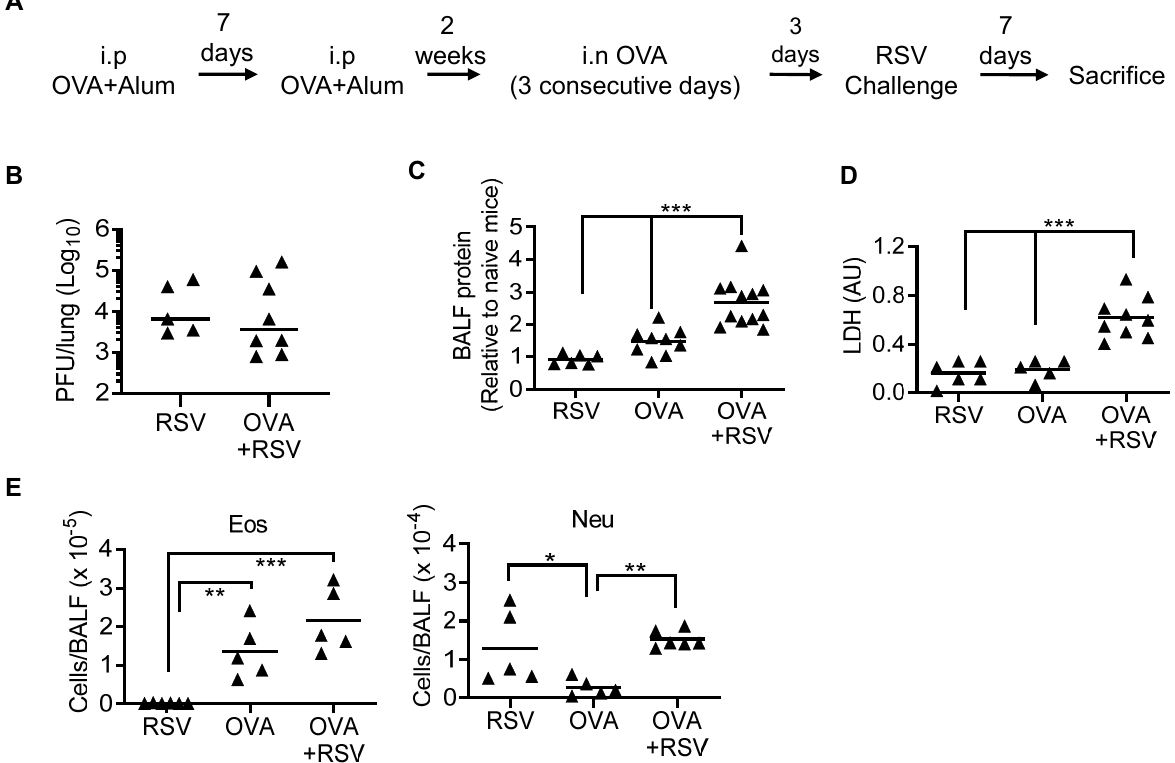
Figure 2. RSV infection of WT mice with OVA-induced asthma increases eosinophilic and neutrophilic inflammation. ( A ) Scheme of the experimental design. ( B ) Lung RSV titers, ( C ) airway protein and ( D ) LDH levels, ( E ) numbers of airway eosinophils (Eos) and neutrophils (Neu) in the BALF at day 7 after RSV infection of OVA-induced asthmatic C57BL/6 WT mice. Corresponding control mice were treated with PBS. AU, Arbitrary Unit; * p < 0.05, ** p < 0.01, *** p < 0.001, one-way ANOVA with Tukey’s multiple comparisons’ test. Data shown are representative of two independent